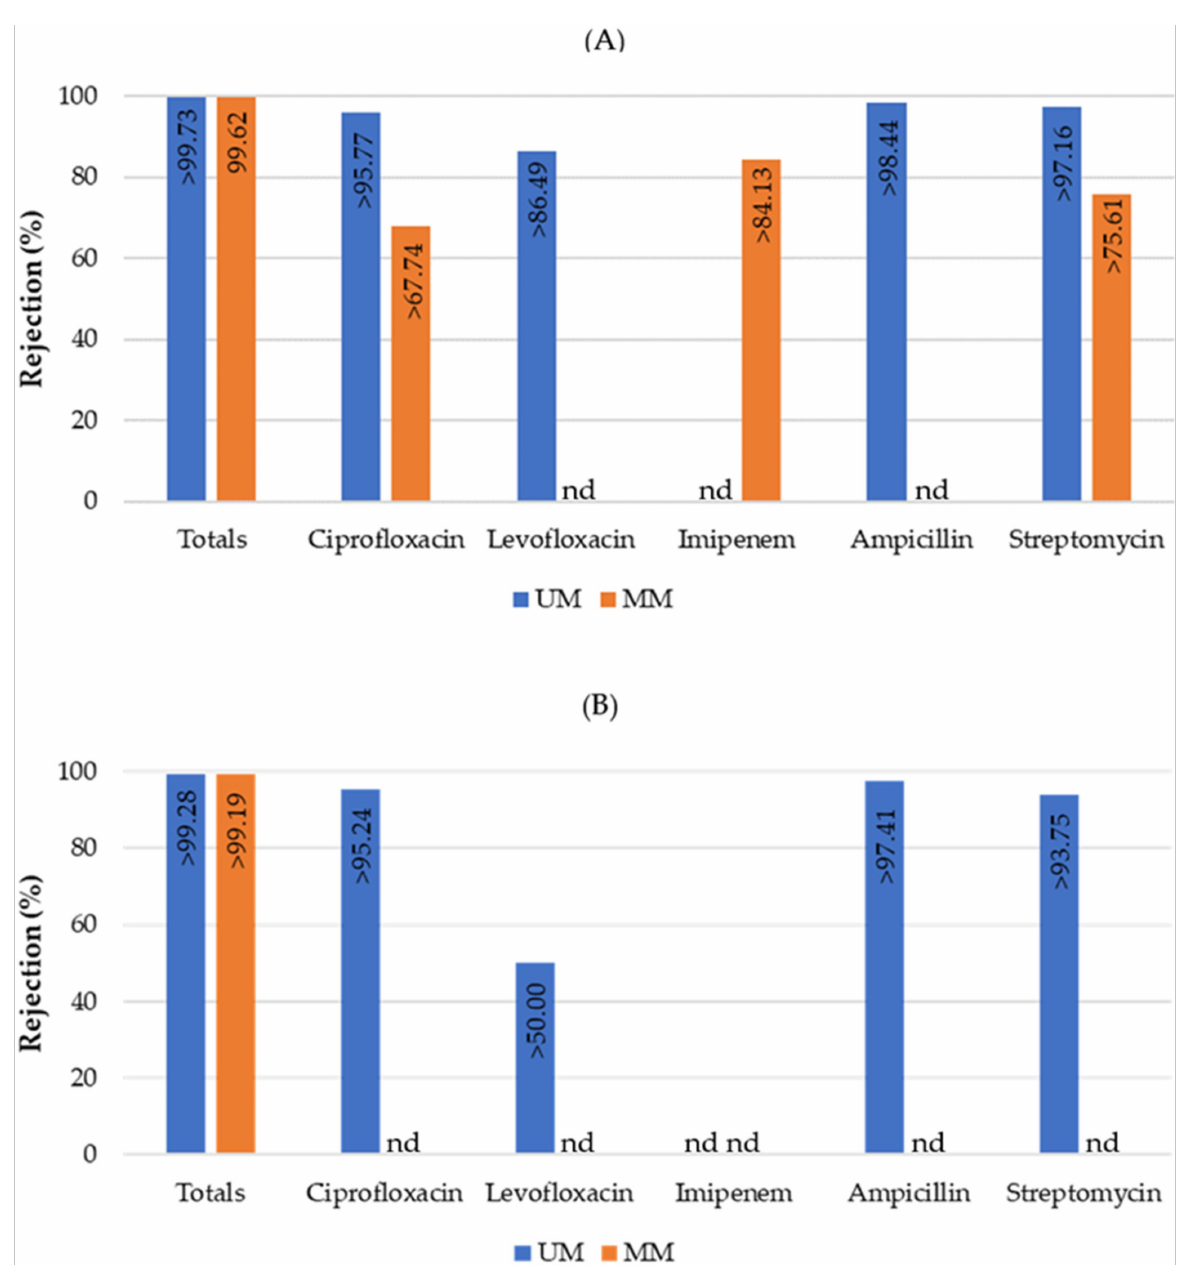
Figure 3. Percent rejection of total coliforms (total bars include resistant and non-resistant bacteria) and total coliforms resistant to various antibiotics ( A ) as well as Escherichia coli and antibiotic-resistant Escherichia coli ( B ) using unmodified (UM) and modified (MM) silicon carbide membranes after 60 min of filtration. The antibiotics tested were ciprofloxacin, levofloxacin, imipenem, ampicillin, and streptomycin. Columns marked “nd” indicate that the target microorganisms were not detected in the untreated surface water samples. Values marked “>” indicate that the target microorganisms were not detected in the treated water